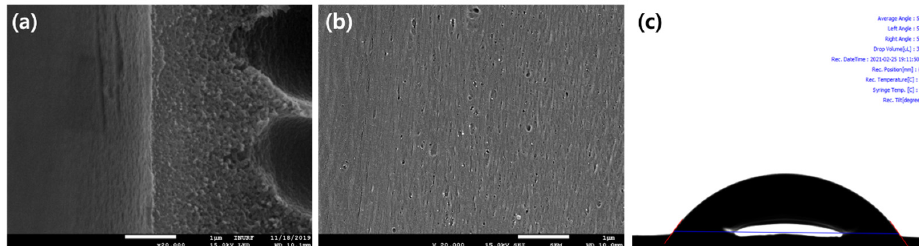
Figure 5. FE-SEM of the hydrophilic hollow fiber membrane. ( a ) cross-section image (20.0 K), ( b ) surface image, and ( c ) contact angle image of the hydrophilic substrate.